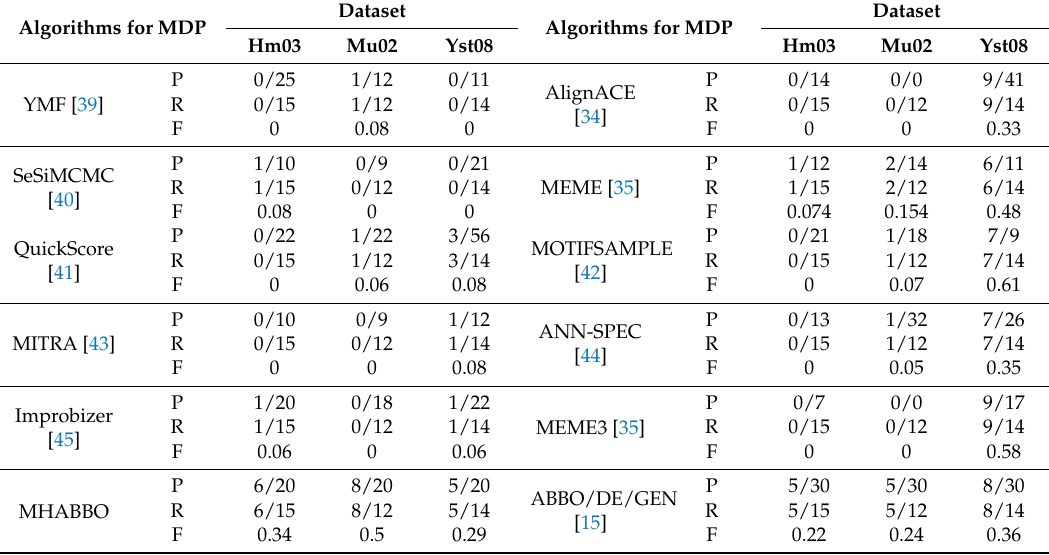
Table 10. Comparisons of MHABBO with other methods on the three datasets: average results (precisions (P), recalls (R) and F-scores